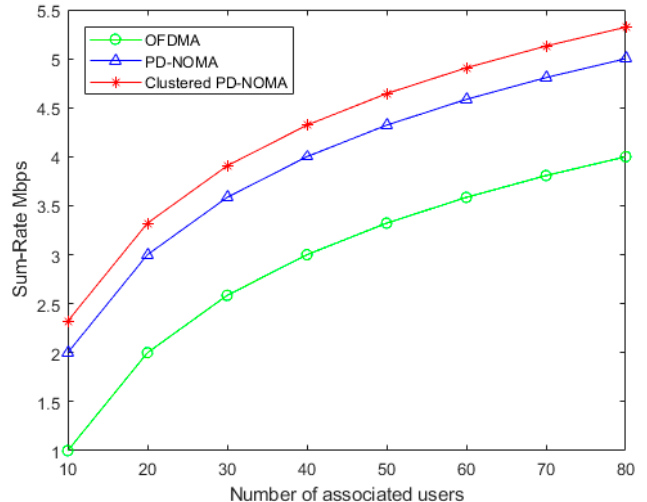
Figure 10. Sum rate comparison with maximum number of associated users occupying the same resource block-comparative resource allocation between OFDMA-, power domain NOMA-, and clustered power domain NOMA-enabled schemes in an ultra-dense HetNet.